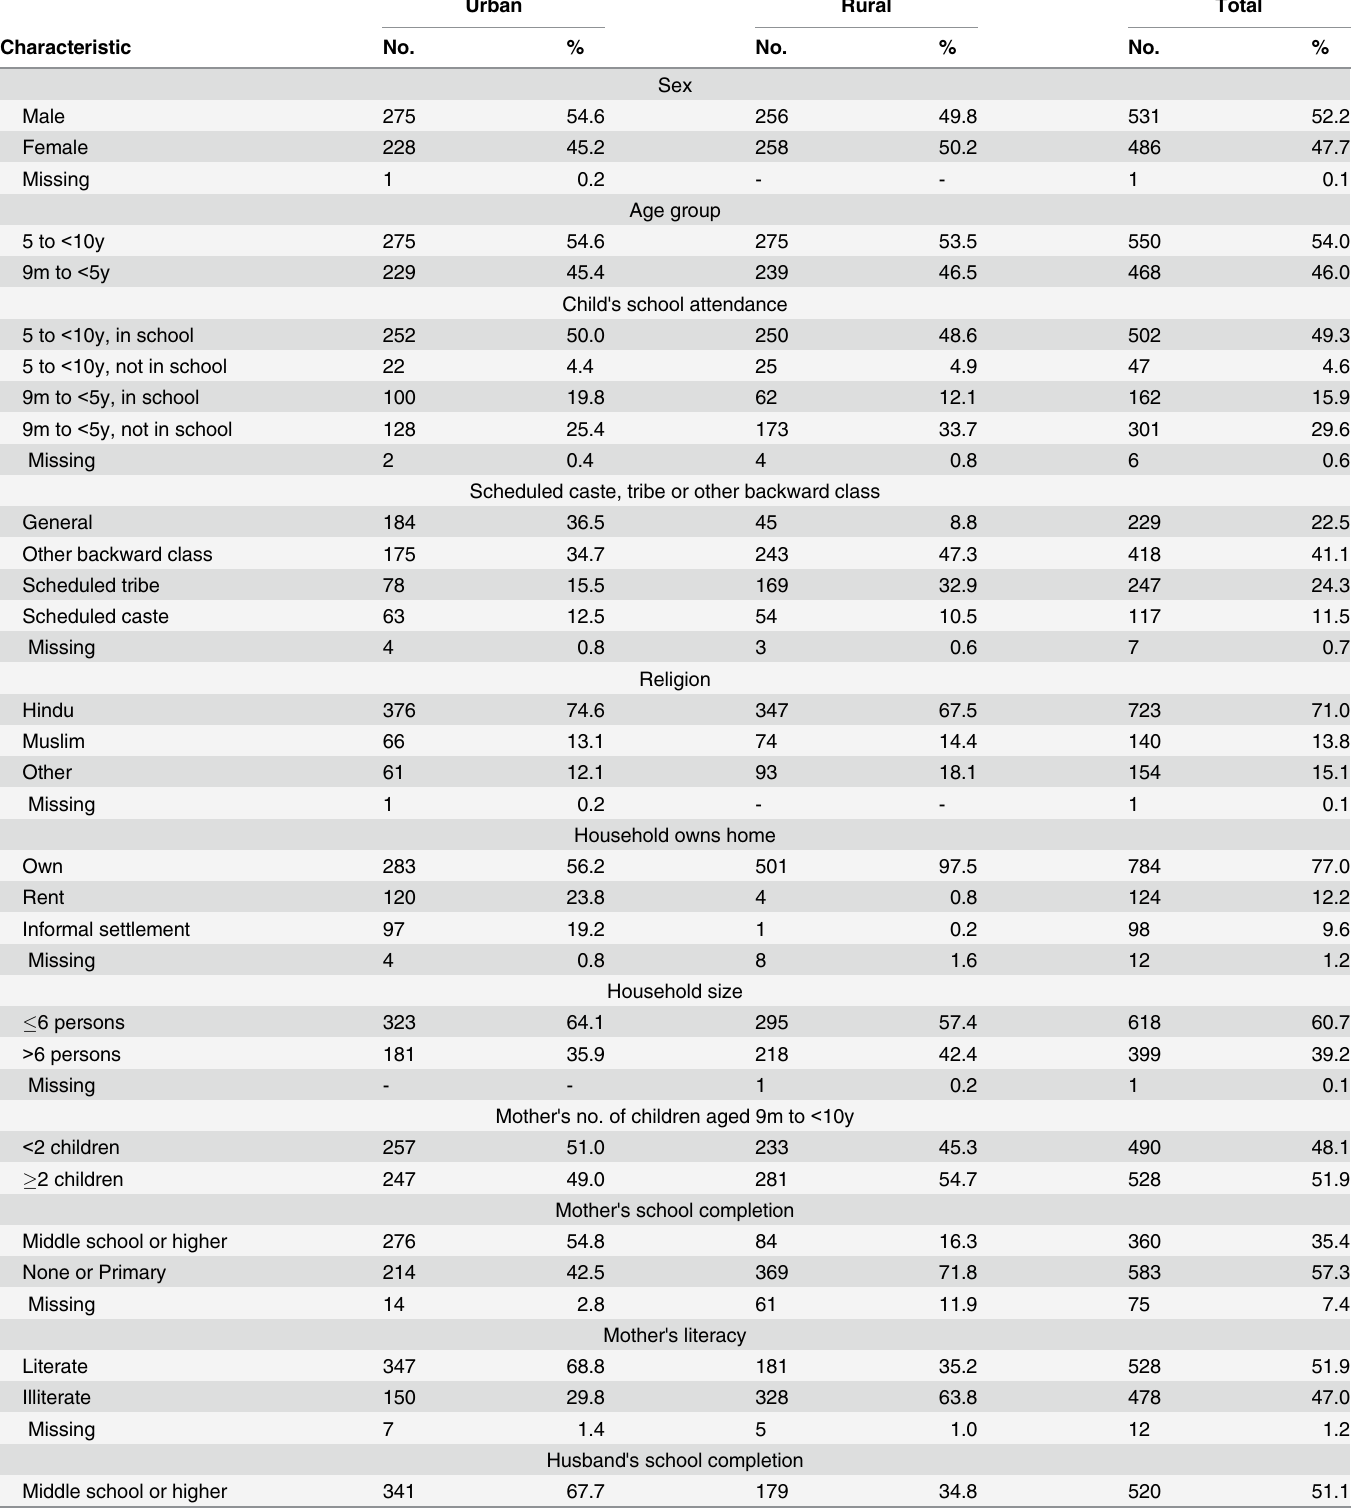
Table 2. Socio-demographic characteristics of children in the urban and rural surveys, Jharkhand, 2012.